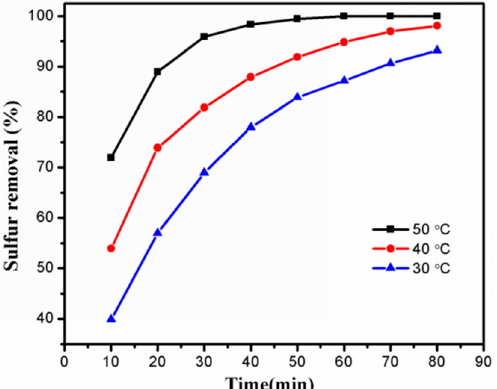
Figure 6. Influence of temperature and reaction time on the oxidative desulfurization of DBT. Conditions: Model oil = 5 mL, n ([Bmim] 5 PMo 11 Co(H 2 O)O 39 ) = 4 μ mol, n (H 2 O 2 )/ n (DBT) = 5, with [Omim]BF 4 (1 mL) as the extractant.